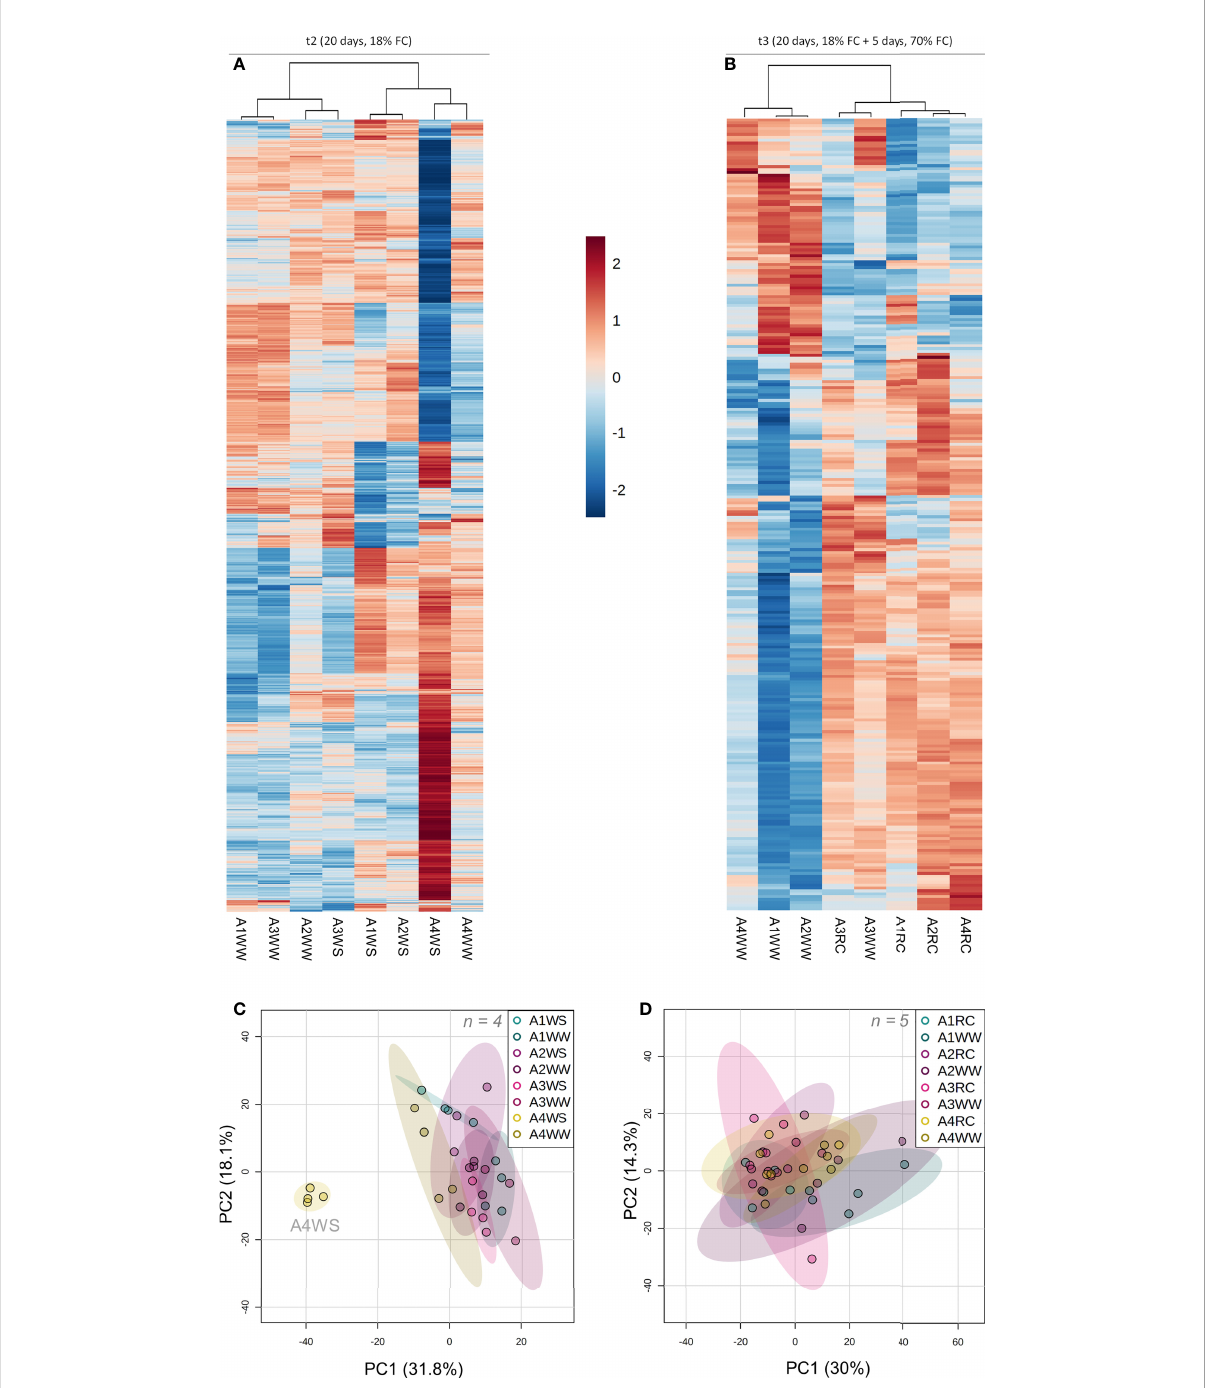
FIGURE 5 Untargeted metabolomic analysis on t2 (20 days) and t3 (20 + 5 days) on 4 genotypes (A1, A2, A3 and A4) and 3 water regimes (well-watered, water-stress and recover): heat map representing top 500 metabolites signi fi cantly different (p<0.01) between groups (group is indicated at the bottom of the fi gure) on t2 (A) and t3 (B) , principal component analysis with all the metabolites on t2 (C) and t3 (D) . Data was normalised by median, cube root transformed and Pareto-scaled (n =